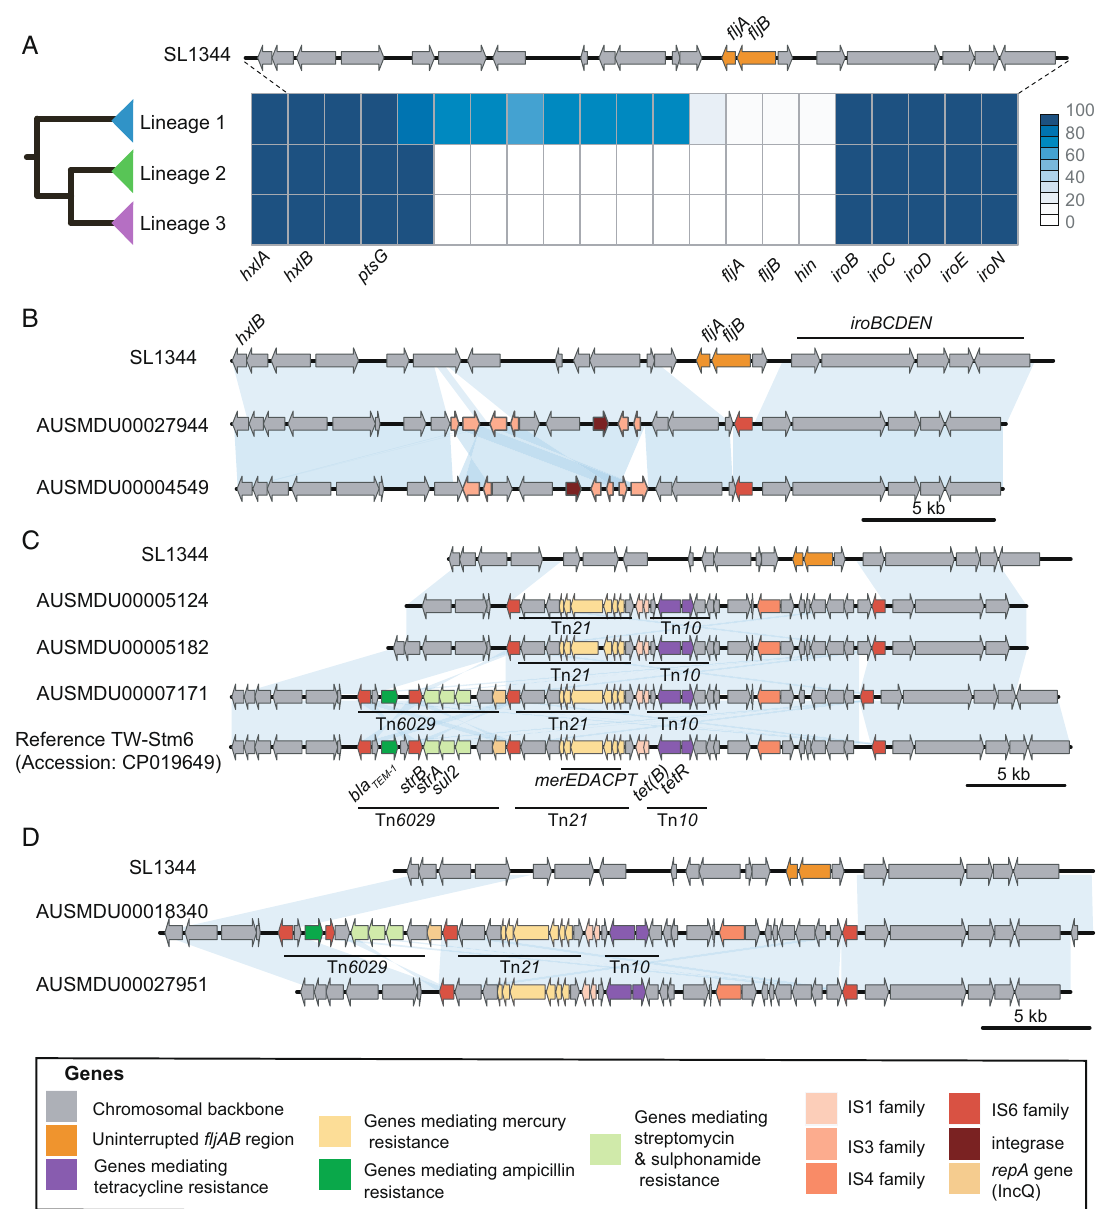
Fig. 2 The interruption of the phase II fl agella differs between lineages. A The frequencies that each gene in the phase II fl agella region appears in each lineage is shown as a heatmap, with dark blue indicating the gene was detected in all isolates and white indicating that the gene was not detected in any. For comparison, genes in the biphasic ST19 S . Typhimurium SL1344 type are shown above. B – D The different interruption patterns of the phase II fl agella in Australian Salmonella 4,[5],12:i:- genomes resolved through long-read sequencing are shown in comparison to the biphasic ST19 S . Typhimurium SL1344 type strain. The blue blocks indicate >95% sequence identity. B Two isolates from humans in Lineage 1. C Two isolates from humans and one bovine isolate from Lineage 2, in addition to the publicly available TW-STm6 isolate collected from a pig in 2014 and D Two isolates from humans in Lineage